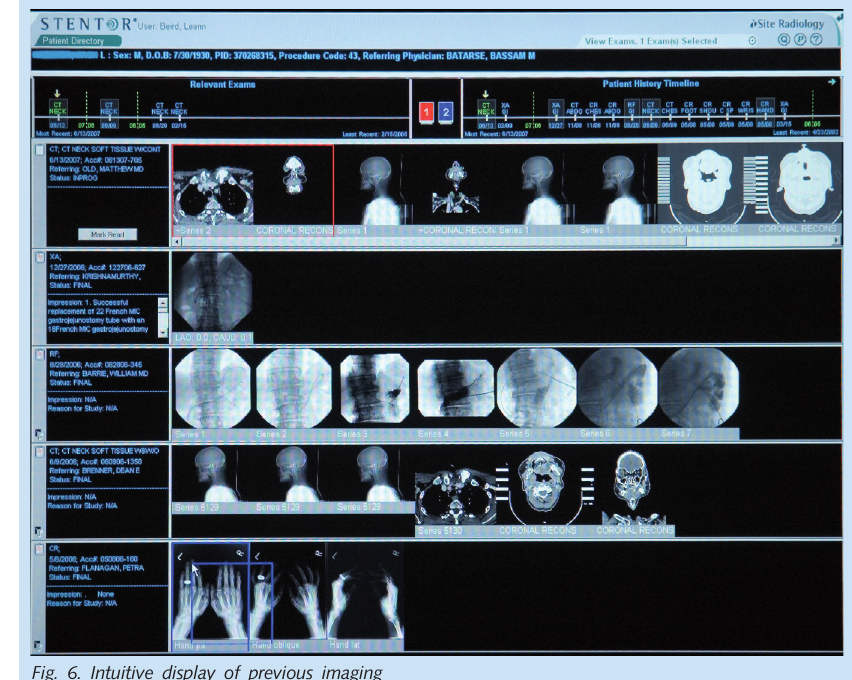
Fig. 6. Intuitive display of previous imaging examinations and conclusions of